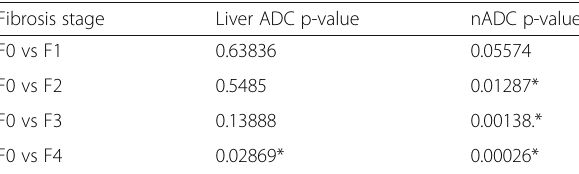
Table 4 ADC and nADC comparison among different fibrosis stages